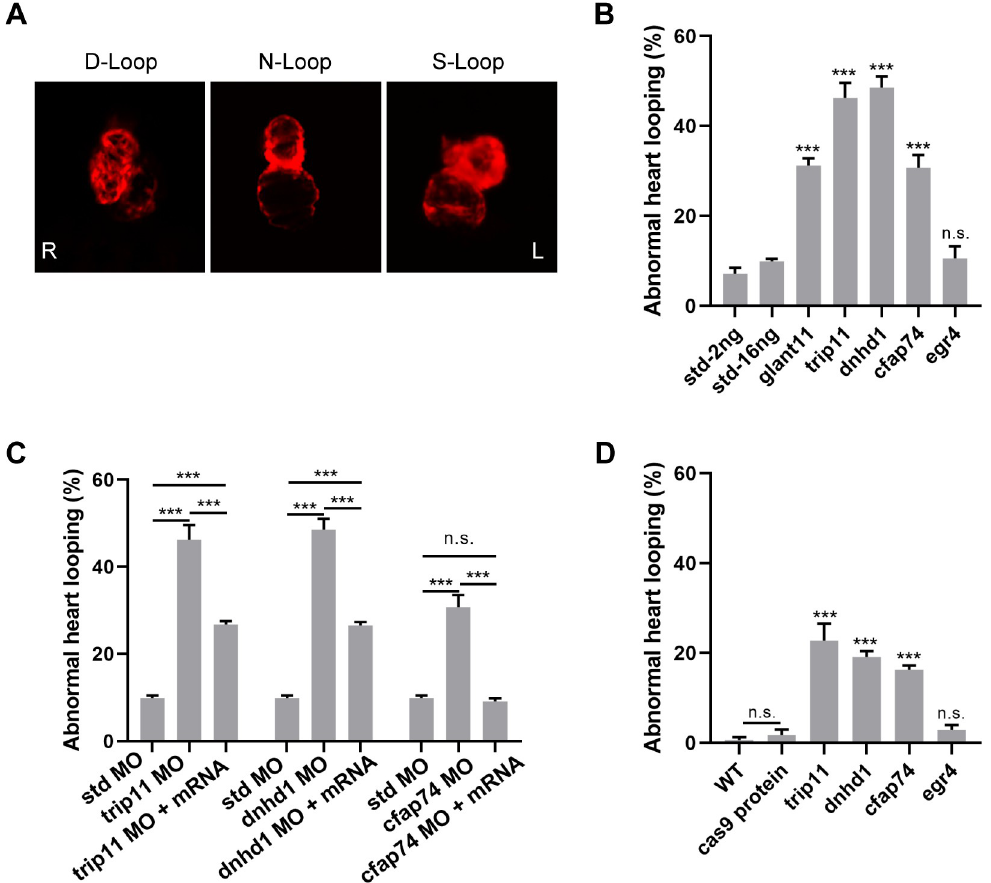
Fig 3. Knock-down of candidate genes disturbed heart looping. (A) Different types of zebrafish heart are shown in Tg (cmlc2: eCherry) morphants in ventral view: dextral loop (normal), sinistral loop (abnormal), and no-loop (abnormal). (B) The percentage of abnormal heart looping with morphants injected. Bars show the total percent of abnormally looped hearts including two types: no-loop and sinistral loop hearts. (C) The corresponding mRNA can rescue LR randomization caused by MO of candidate genes. (D) The ratio of the abnormal heart looping of embryos generated by co-injection of zebrafish Cas9 mRNA and gRNA. Each experiment was repeated at least 3 times with > 50 embryos examined for each group every time. Standard MO (Std) is used as the negative control. galnt11MO is used as the positive control. Chi- squared test (continuity corrected) was used in B, C and D; � P < 0.05, �� P < 0.01, ��� P < 0.001, respectively vs. Std-16ng ( glant11 , trip11 , dnhd1 , and cfap74 ) or Std-2ng ( egr4 ). WT, wild type.